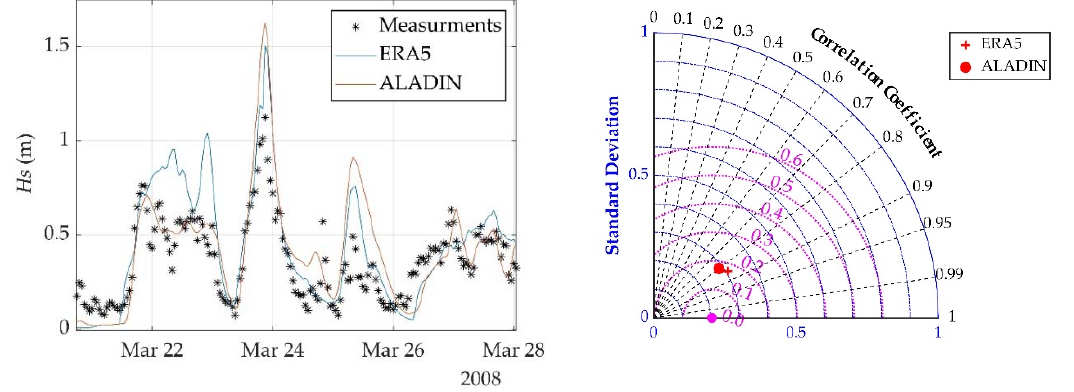
Figure 10. ( left ) Wave time series excerpt of measured at wave buoy location in front of Split (Figure 3) and modeled significant wave heights forced by ERA5 and ALADIN wind products (wind field grids shown on Figure 3) ( right ) Taylor diagram showing statistical information for the time series